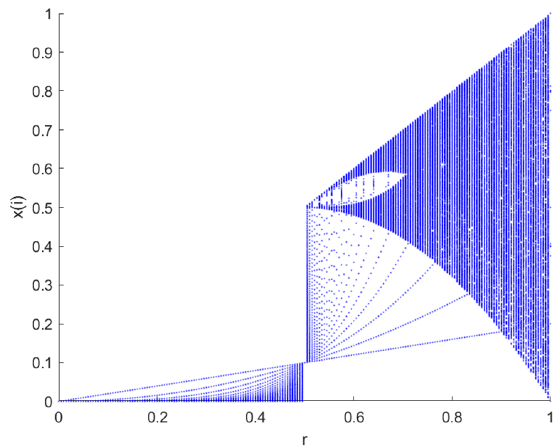
Figure 2. Tent map bifurcation diagram [28].